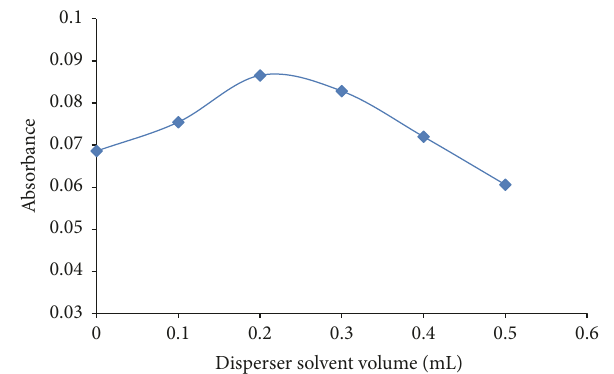
Figure 3: The effect of dispersive solvent volume on absorbance of lead for SFODME. Extraction circumstances: Pb: 10 𝜇 gL −1 ; pH: 9; extraction solvent, 1-undecanol (100 𝜇 L); sample volume, 10mL; pH: 9; % 1.6 NaCl chelating reagent [PAN], 1 × 10 −4 molL −1